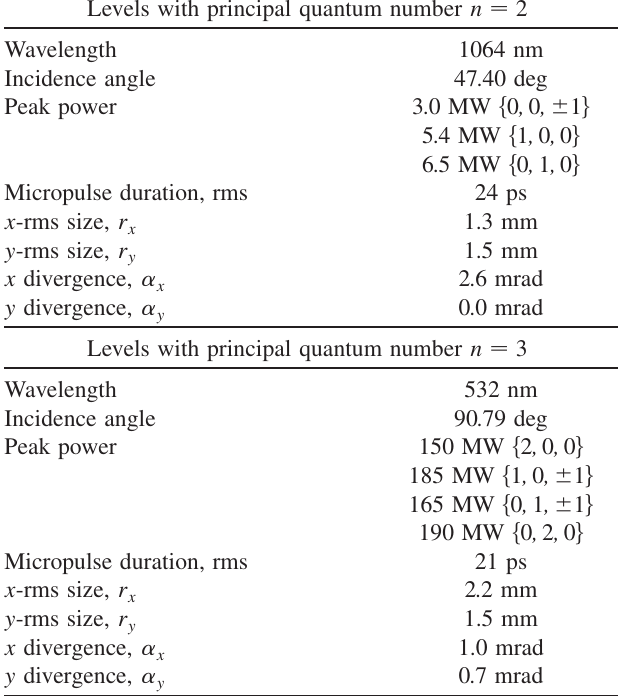
TABLE IV. The optimal parameters of the laser beam required for 98% of the stripping efficiency.